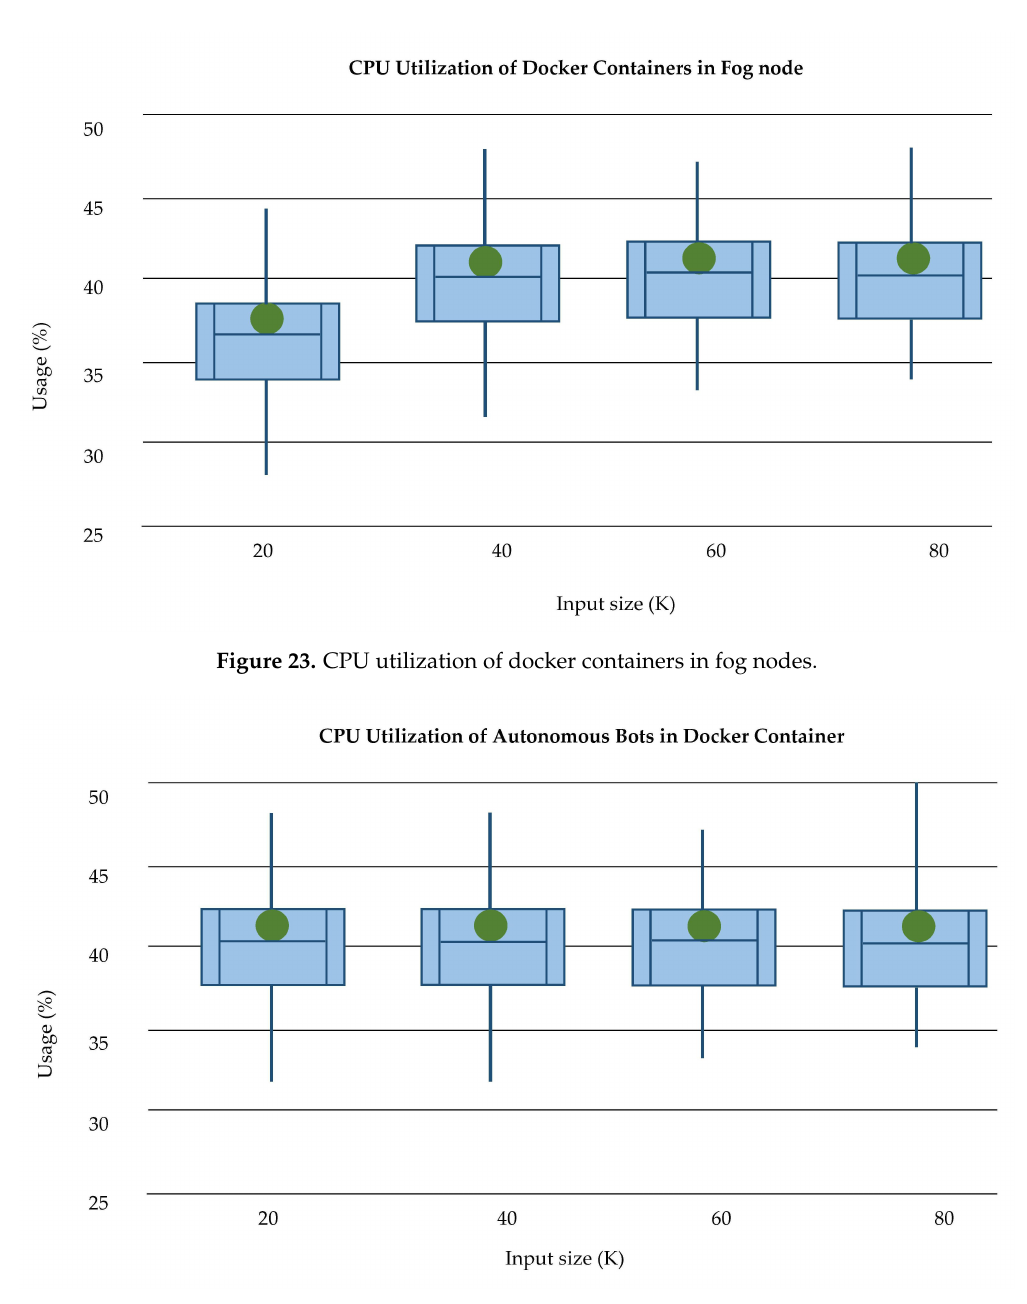
Figure 24. CPU utilization of autonomous bots in docker